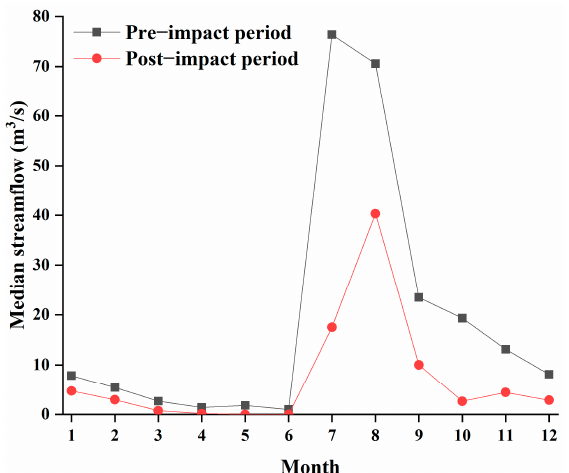
Figure 8. Monthly median streamflow.